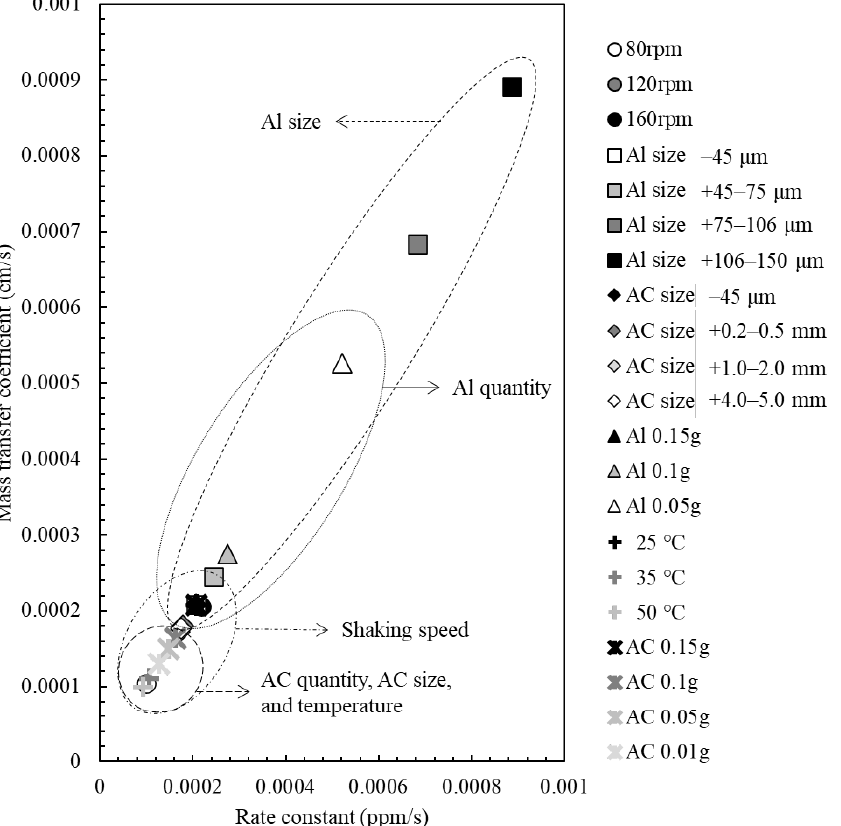
Figure 7. The plot of rate constant and mass transfer coefficient based on all recovery results in the present study.